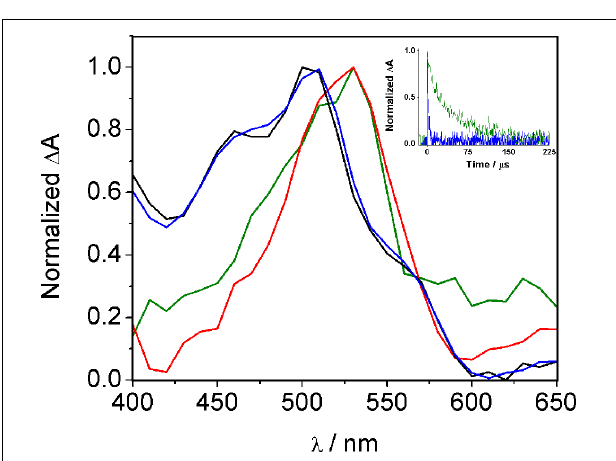
FIGURE 4 | Normalized transient absorption spectra of HTB (black line), HTB/ubiquitin 1:1 (blue line), HTB-ubiquitin (green line) and HTB-butylNH 2 (red line) adducts in phosphate buffer N 2 -flushed solutions, 0.5 µ s after the laser pulse. Inset: normalized decay traces of HTB /ubiquitin 1:1 (blue) and HTB-ubiquitin adduct (green).